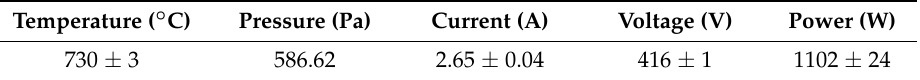
Table 1. Average and standard deviations of parameters used in plasma